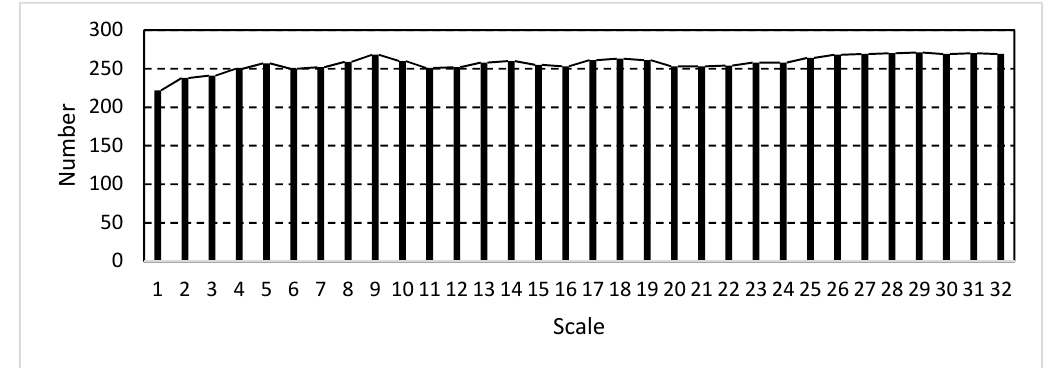
Figure 6. Number of heterogeneous scenes at each scale from 15 × 15 to 77 × 77 TM pixels at a step of 2 TM pixels.